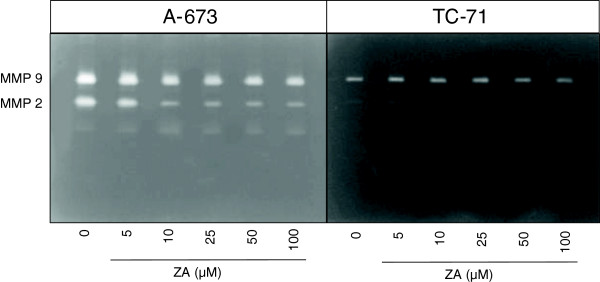
Effect of zoledronic acid (ZA) on MMP activity analyzed by gelatin zymography. MMP-2 and MMP-9 activities were evidenced at the corresponding molecular weight. Subconfluent A-673 and TC-71 human ES cell lines were cultured in the presence or absence of zoledronic acid at increasing concentrations (5 to 100 μM) for the last 24 h of culture. The supernatant was then harvested and the same volume submitted to electrophoresis in a gel containing gelatin (see Methods section).